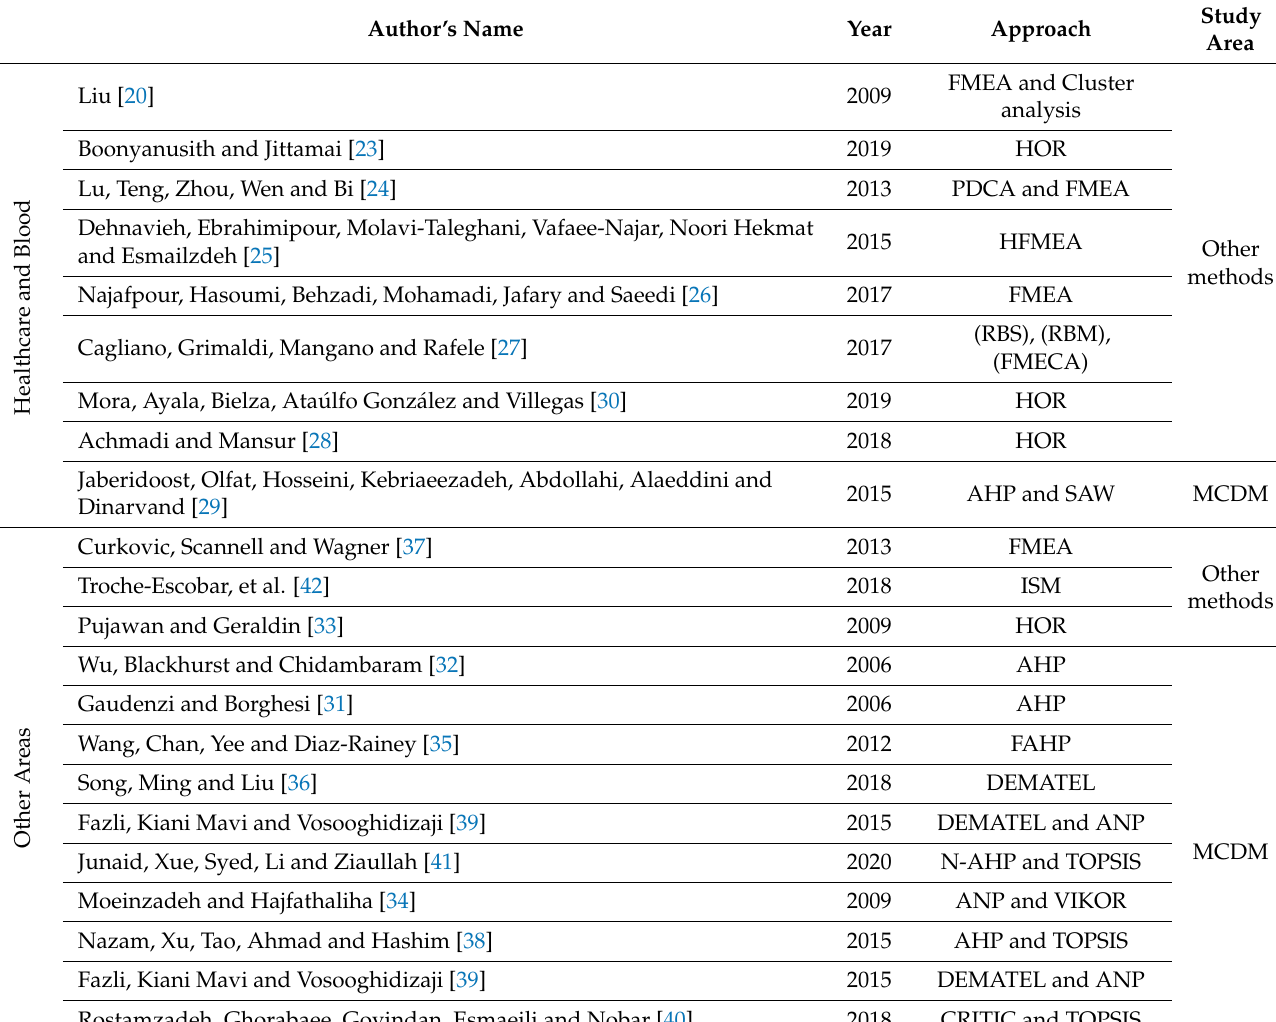
Table 1. Summary of previous